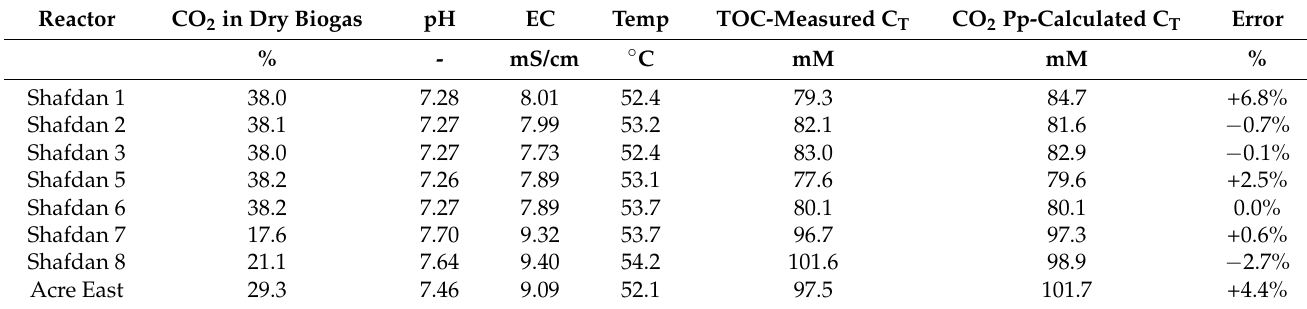
Table 4. Comparison of results of TOC-measured vs. estimated C T values obtained from the knowledge of the CO 2 percentage in the